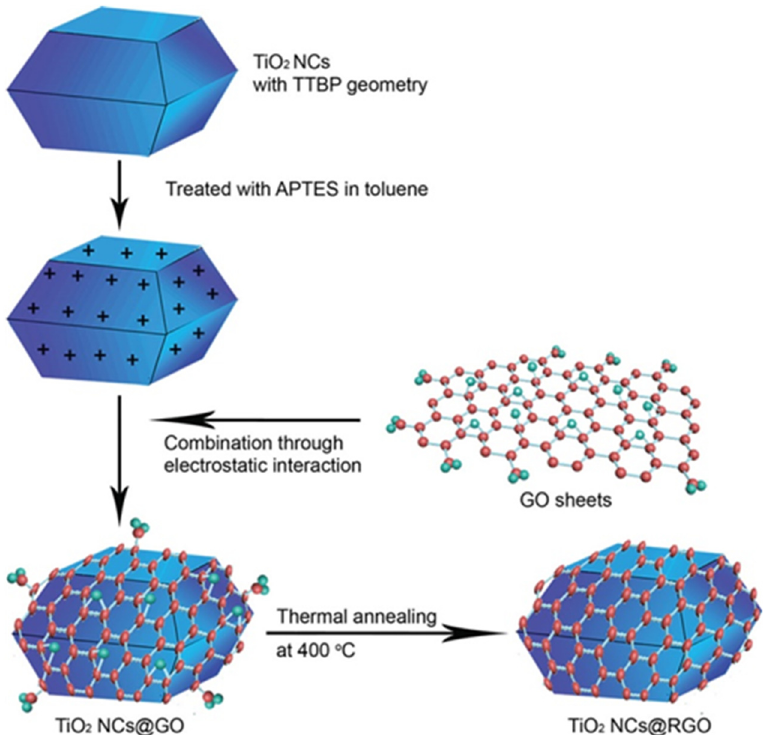
Figure 2. Schematic illustration for synthesis of TiO 2 NCs@RGO composites (RGO–rGO). Reprinted with permission from [39]. Copyright 2014 John Wiley and Sons.